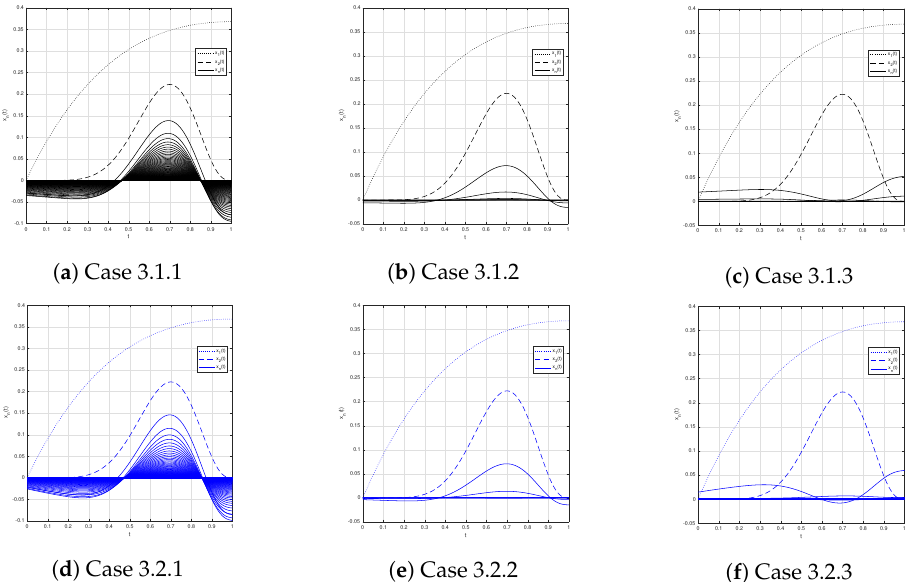
Figure 4. Convergence behavior of the sequence { x n ( t ) } with and without the extrapolation factor ( θ n ) for Case